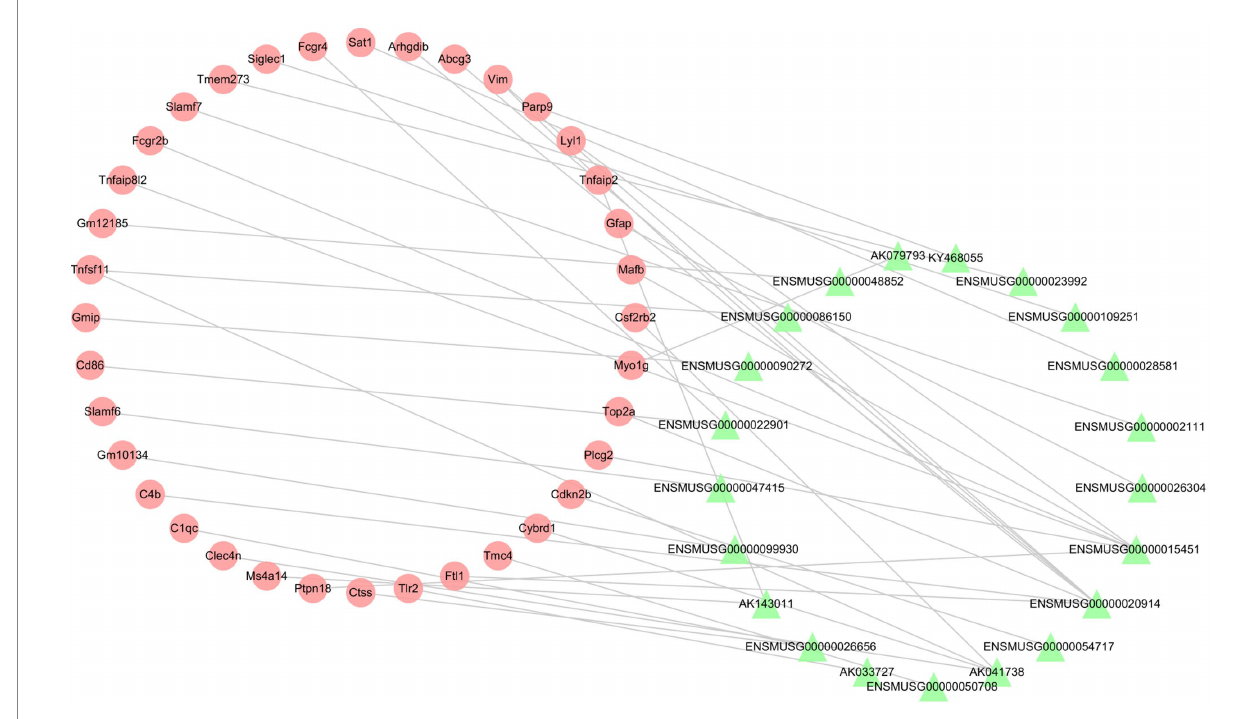
FIGURE 7 The lncRNA-mRNA co-expression network post-ICH. The red circles represent mRNAs, and the green triangles represent